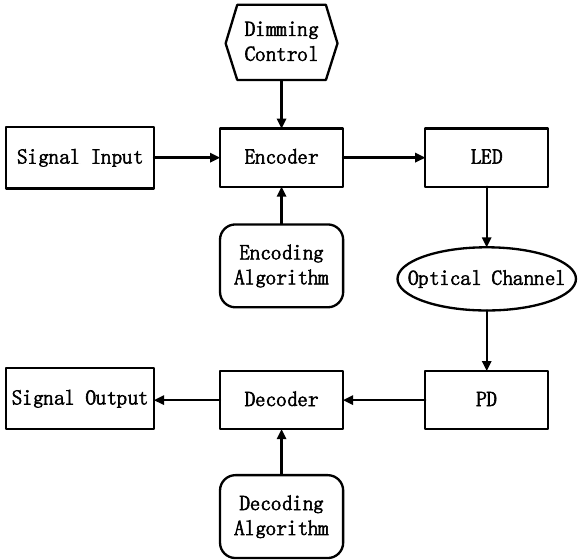
Figure 2. System block diagram of the ML-MTSC scheme.